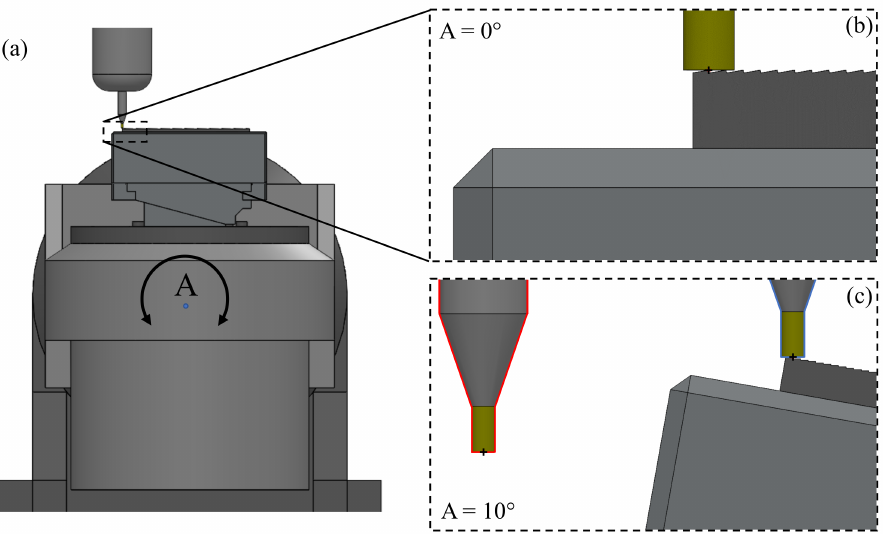
Figure 7. Four-axis micromilling of ATR samples: ( a ) machine tool overview, ( b ) tool orientation for A = 0 ◦ , and ( c ) tool orientation without RTCP on as 3+1-axis machining (red outline) and with RTCP on (blue